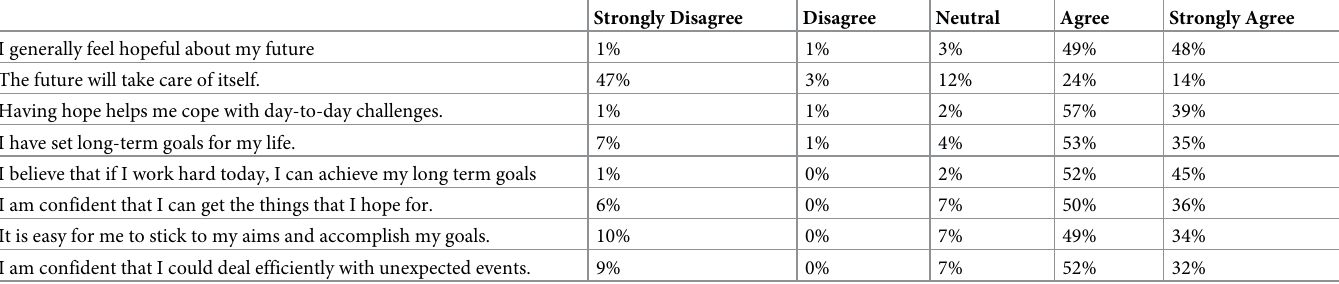
Table 3. Hope responses, by